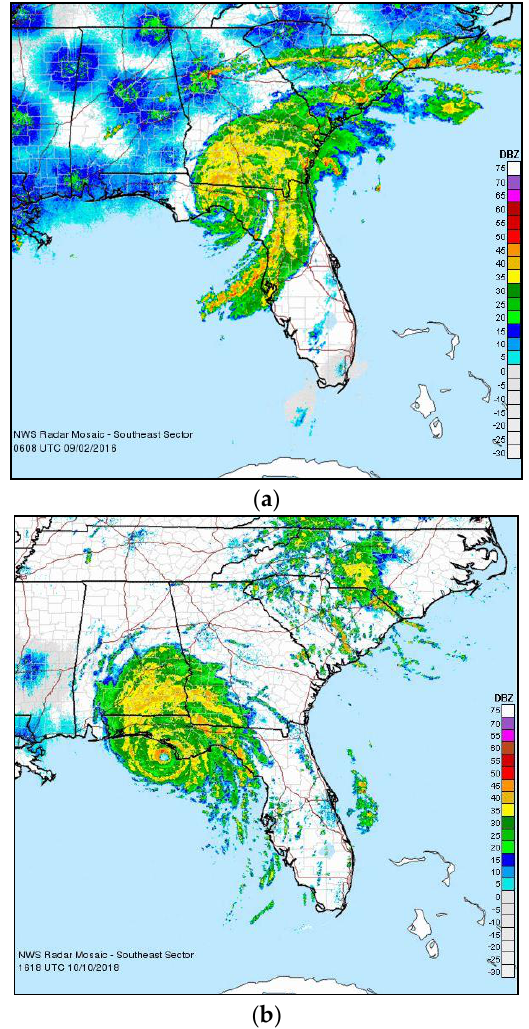
Figure 2. ( a ) Hurricane Hermine's [35] ( b ) and Hurricane Michael ’s [36] paths over Tallahassee, FL.